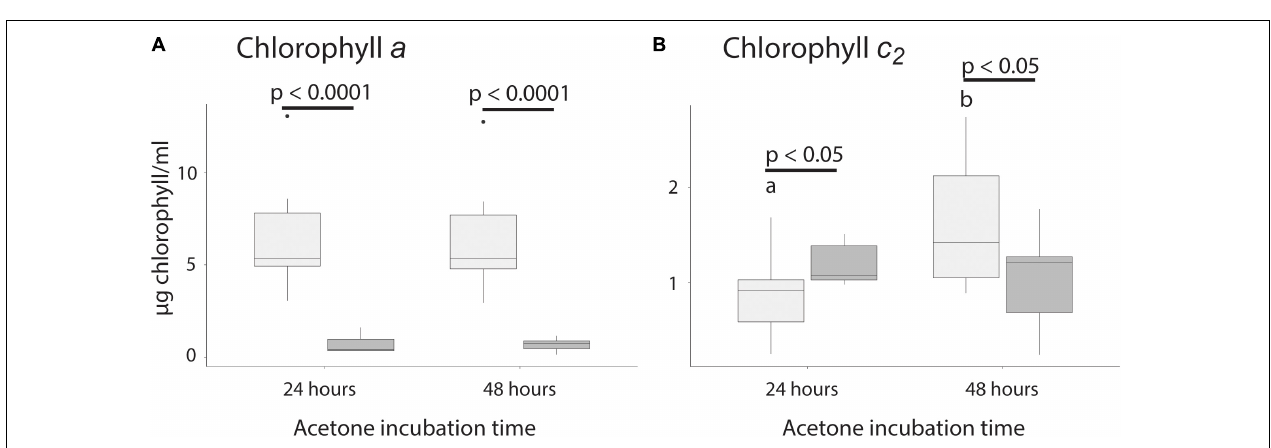
FIGURE 3 | Chlorophyll extraction time for chlorophyll a and c 2 . (A) Extraction of chlorophyll a between initial and secondary extraction after 24 and 48 h. (B) Extraction of chlorophyll c 2 between original and refilled vials after 24 and 48 h. Significant differences between fills are indicated by a bar and the associated p -value, while significant differences between time points are indicated using different letters.